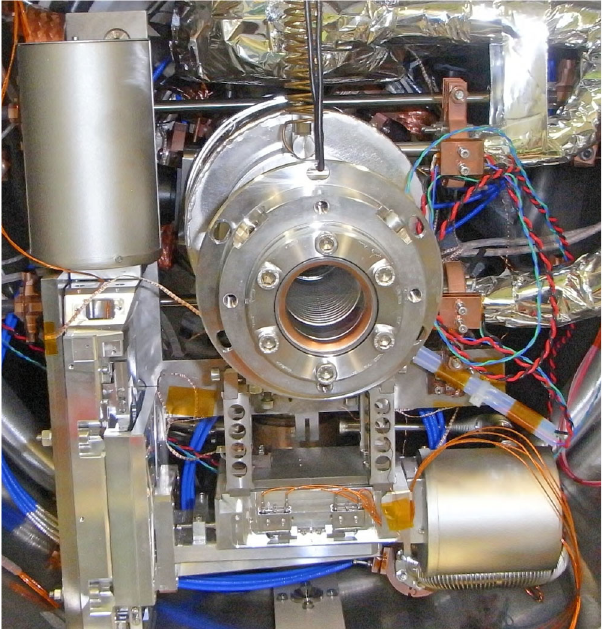
FIG. 8. Fully dressed SC solenoid with shielded steppers, main magnetic shield around the yoke, installed temperature sensors, isolated helium connection lines, and thermal anchors of the connecting (black and red) and measuring (cyan and blue) leads. The picture was taken after the insertion of the cold mass into the gun cryostat.